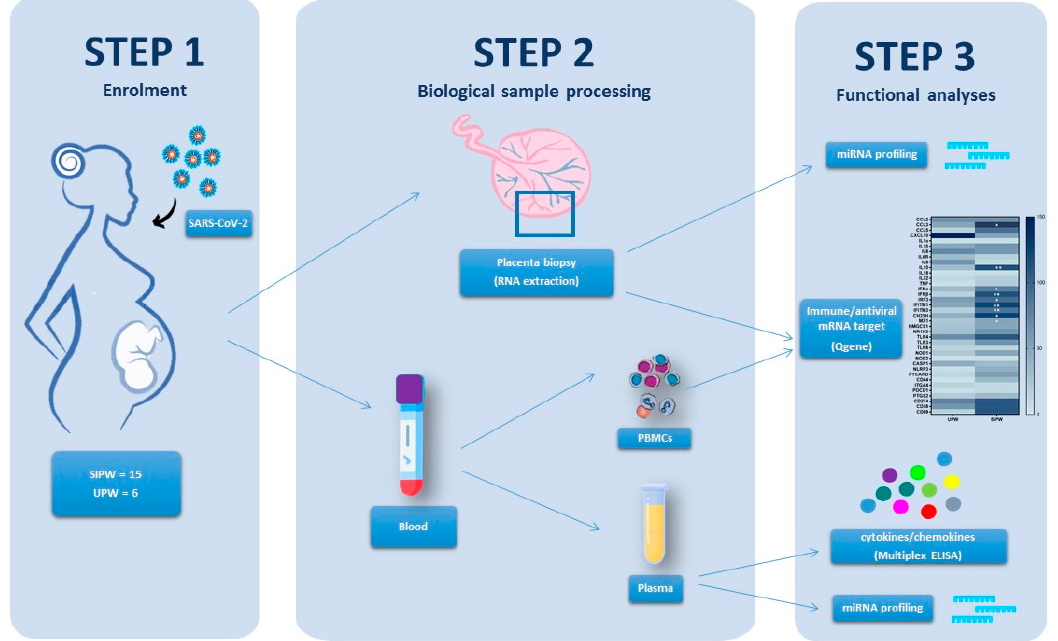
Figure 1. Graphical representation of the study workflow. Fifteen-SIPW and 6 UPW were enrolled in the study ( Step1 ). At delivery, blood and placenta biopsies were collected from obstetrics and gynaecology units and immediately conveyed to the laboratory of immunology to be processed for further analyses ( Step 2 ). Analyses of miRNA ( n = 84), antiviral/immune mRNA target ( n = 74) expression and cytokine/chemokines production ( n = 27) was assessed on the processed biological samples ( Step 3